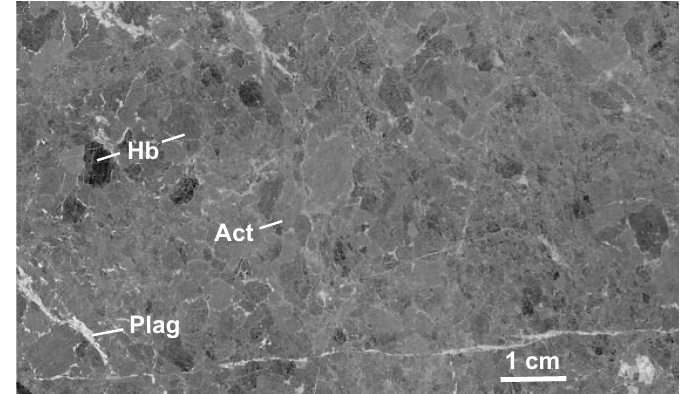
Fig. 3 – Scanned hand sample of Belizário ultramafic amphibolite shows darker hornblende and lighter actinolite crystals in equivalent contents; pla- gioclase is present in matrix and in many large and small veins.